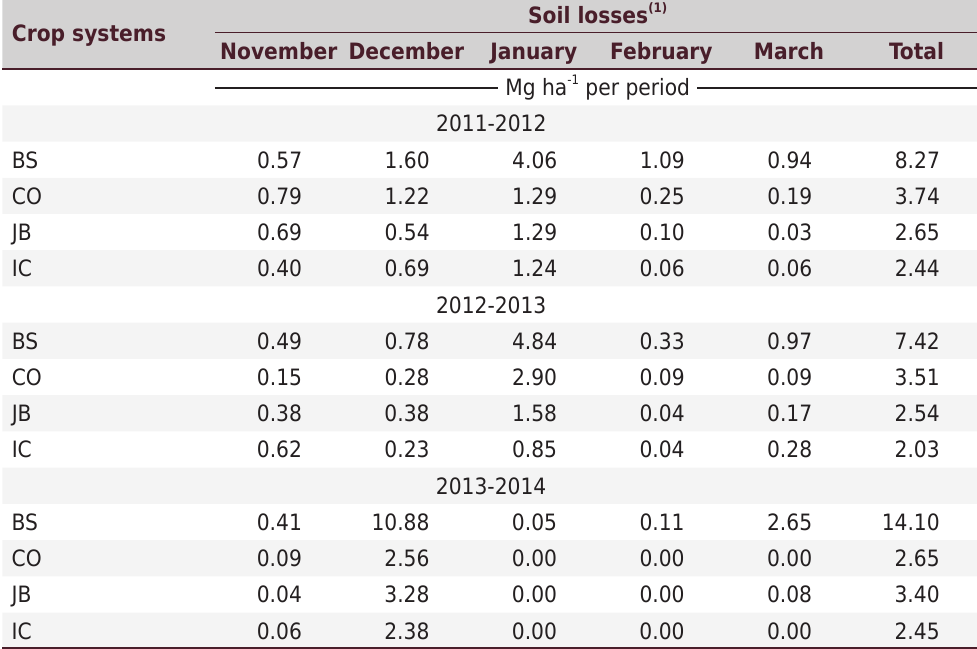
Table 4. Soil losses by water erosion in three crop systems, for each month and for the total period, from November to March of 2011 to 2012, 2012 to 2013, and from 2013 to 2014, in Lavras, MG, Brazil Crop